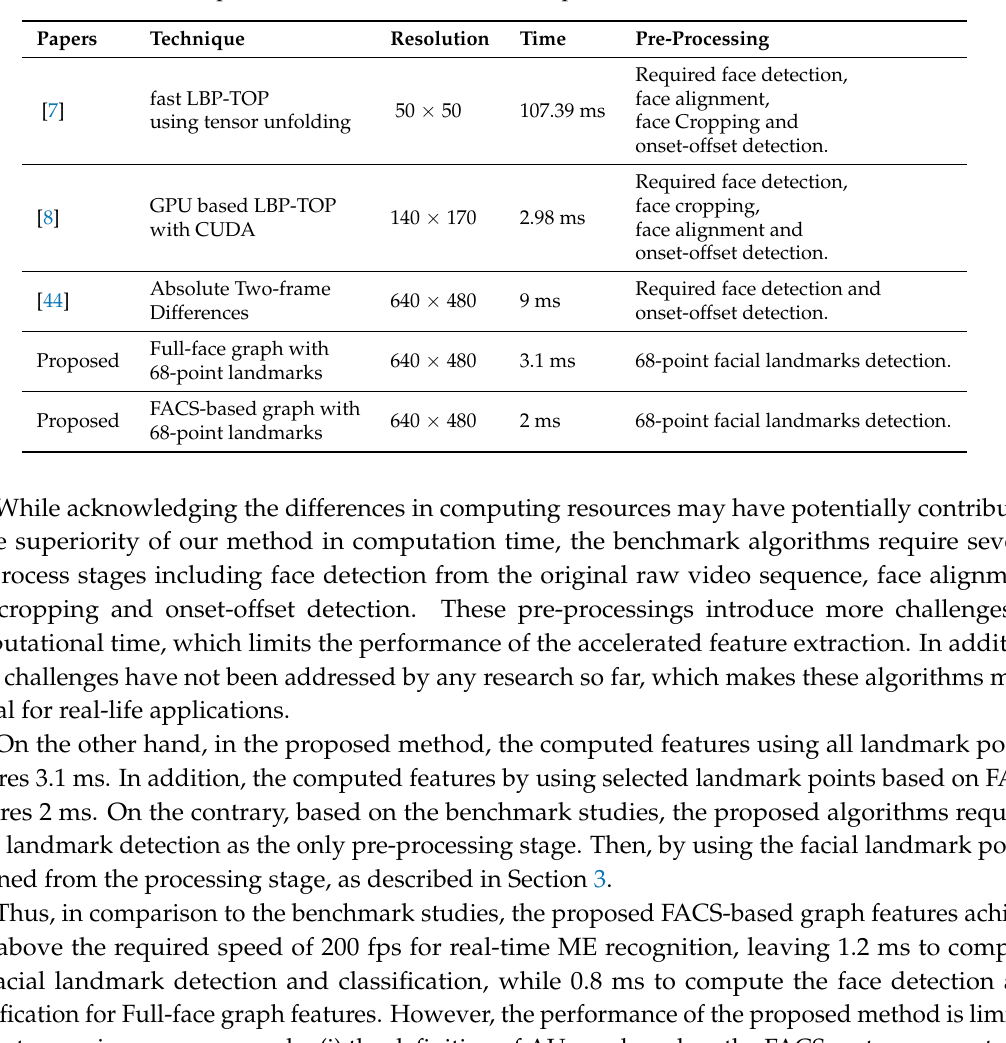
Table 9. Computational Performance for the Proposed and Conventional